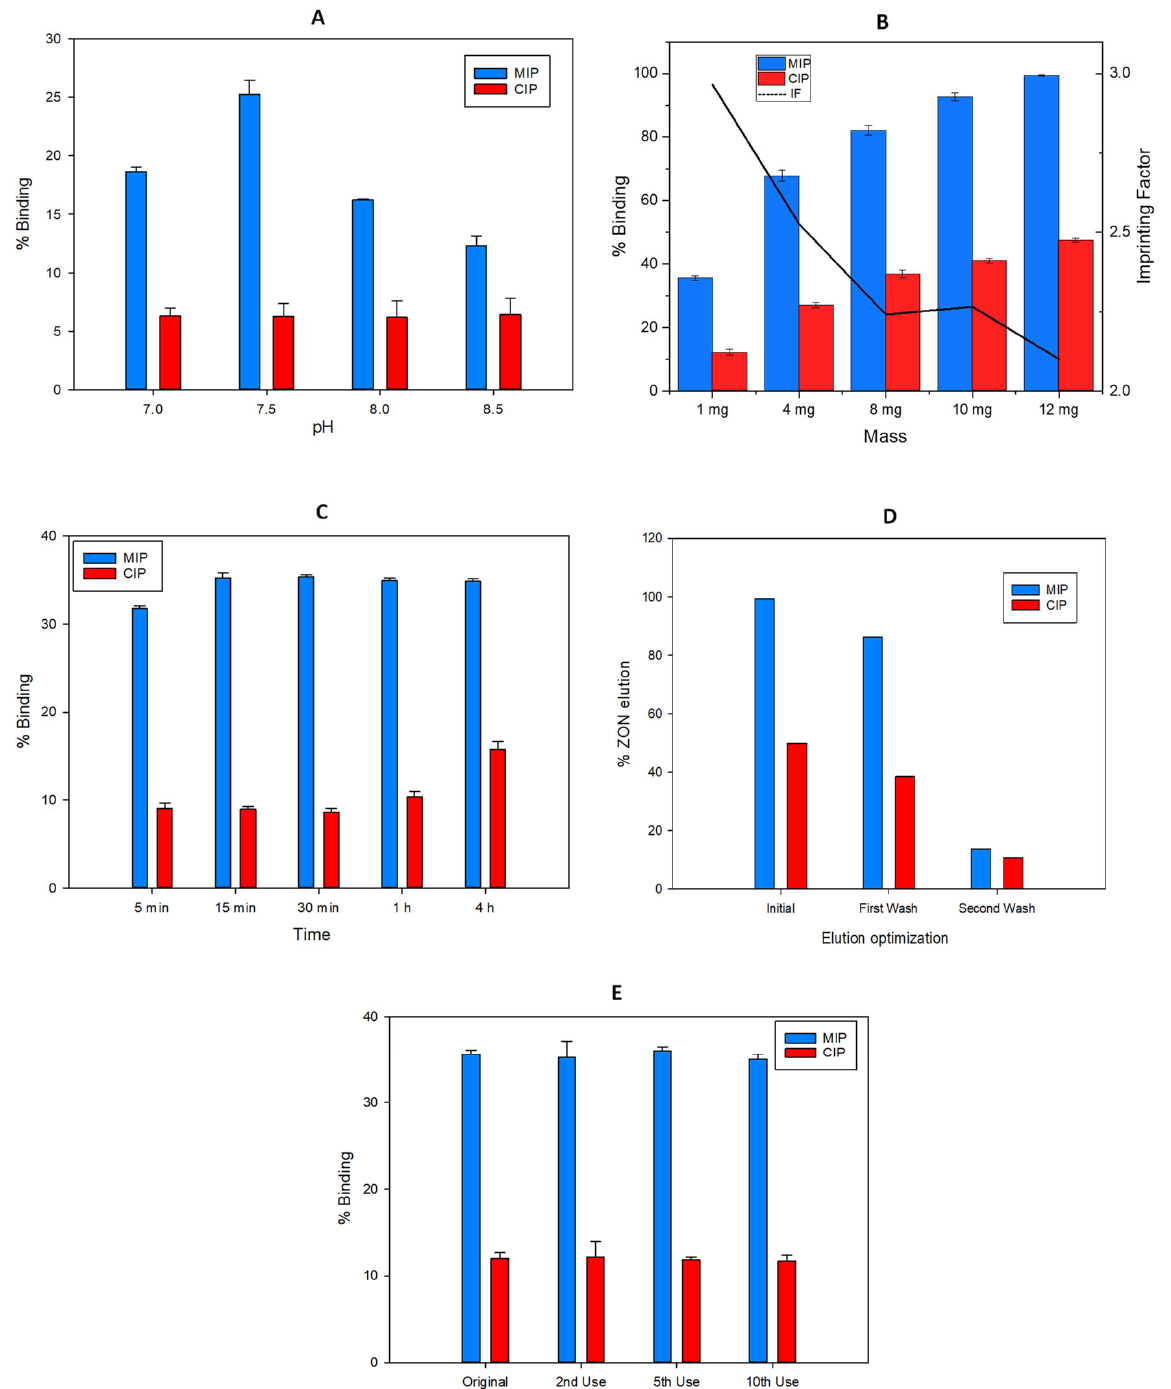
Figure 7. Optimization in terms of binding recovery (%) of the MISPE parameters: ( A ) pH incuba- tion, ( B ) Mass of Fe 3 O 4 @SiO 2 @MIP particles, ( C ) Incubation time, ( D ) Elution solvent volume and ( E ) Material reuse, for the extraction of ZON.